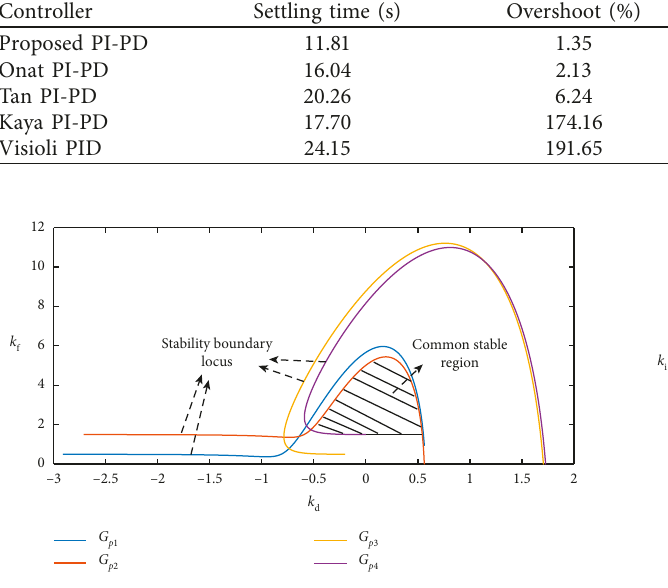
Figure 8: Stability boundary loci of inner-loop PD controller for uncertain systems in example C.